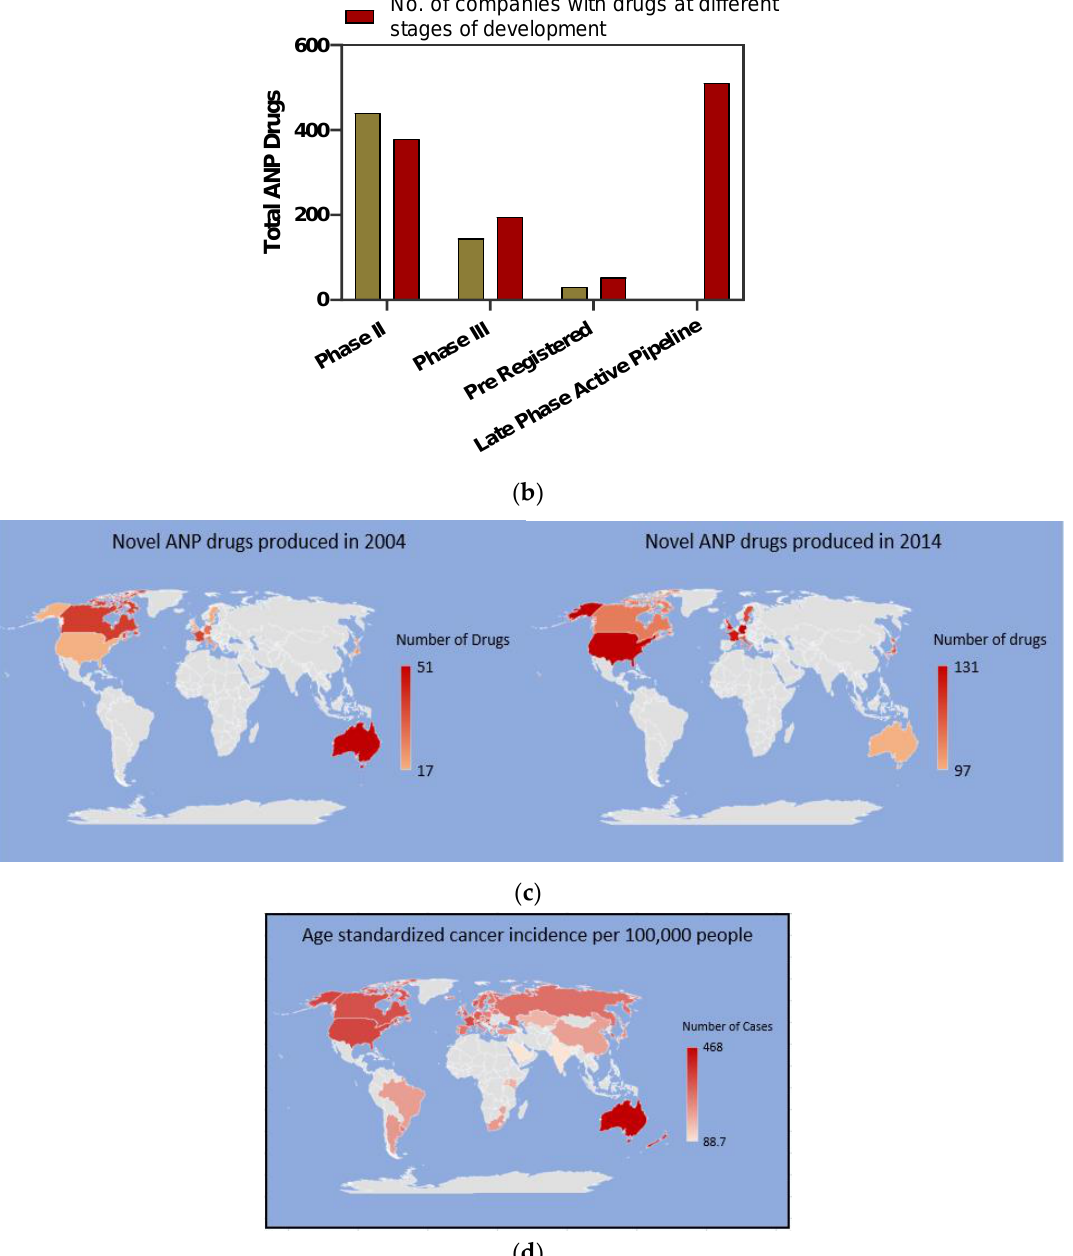
Figure 1. ( a ) Number of antineoplastic (ANP) drugs approved between 1995 and 2019 in USA and European Union (EU) [7,13–15]; ( b ) The Global Late Phase Oncology Pipeline in 2015 [8]; ( c ) comparative global heatmap of ANP drug produced in some select countries in 2004 and 2014 [10]; ( d ) age standardized cancer incidence in select countries in 2018 [12]. (Phase II and Phase III refers to ANP drugs that are at second and third phase of clinical trials, respectively).